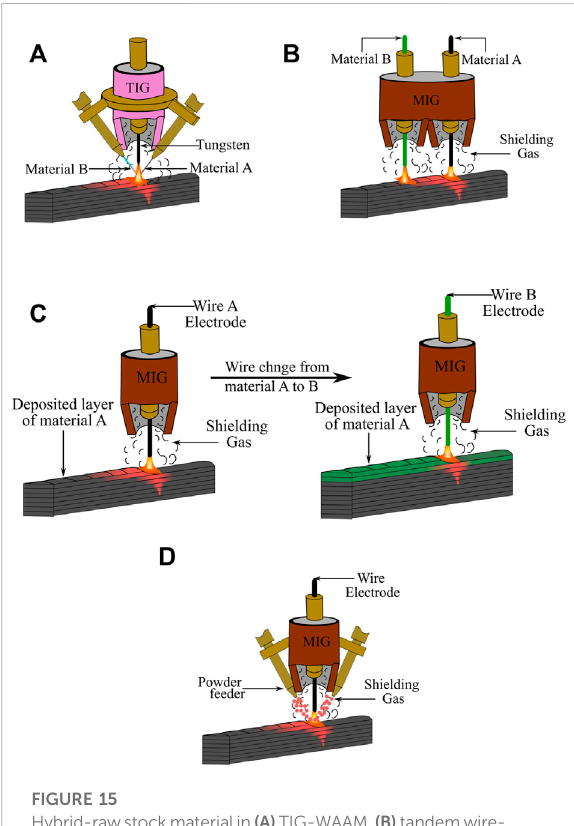
FIGURE 15 Hybrid-rawstockmaterialin (A) TIG-WAAM, (B)